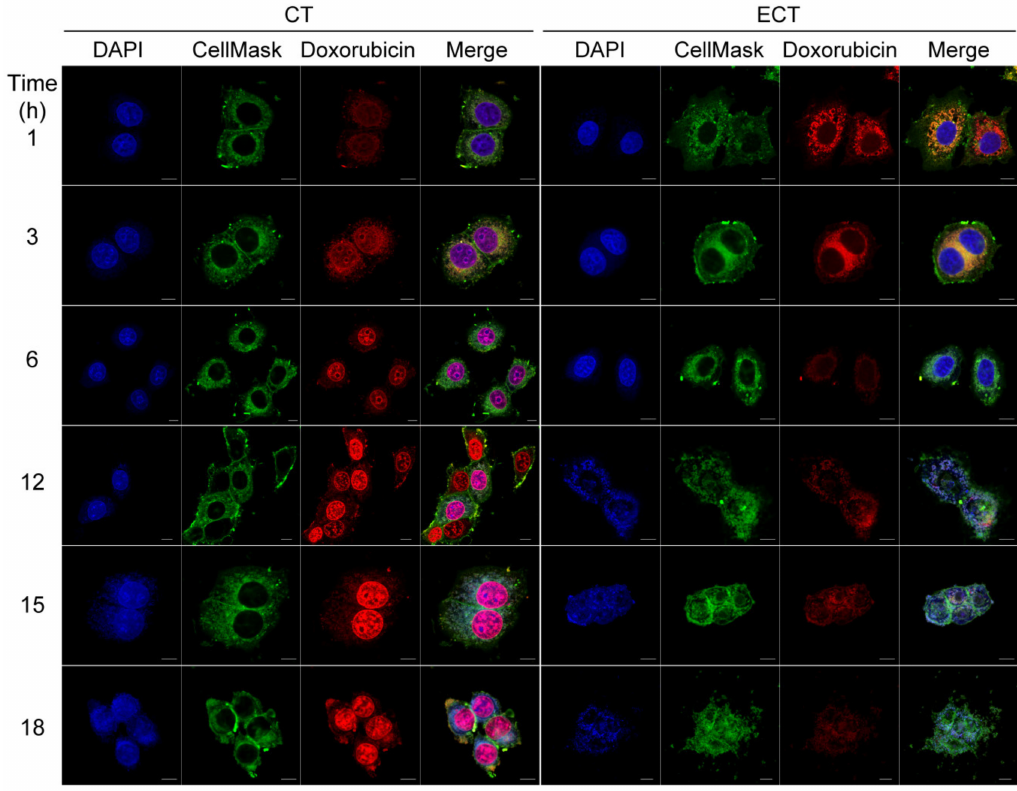
Figure 6. Intracellular distribution of doxorubicin (DOX = 1.7 µ M) in MCF-7 / WT cells treated with chemotherapy only (CT) or electropermeabilized with DOX (ECT, EP-DOX) (EP = 1000 V / cm, 100 µ s, 8 pulses, 1 Hz) after di ff erent incubation times. Scale bar = 10 µ